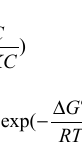
Figure 10. EDS spectrum of Al-2007 alloy surface: (a) before immersion; (b) after 2 h of immersion at 20 °C in 3.5% NaCl solution; (c) after 2 h of immersion at 20 °C in 3.5% NaCl with 1500 ppm mad honey.